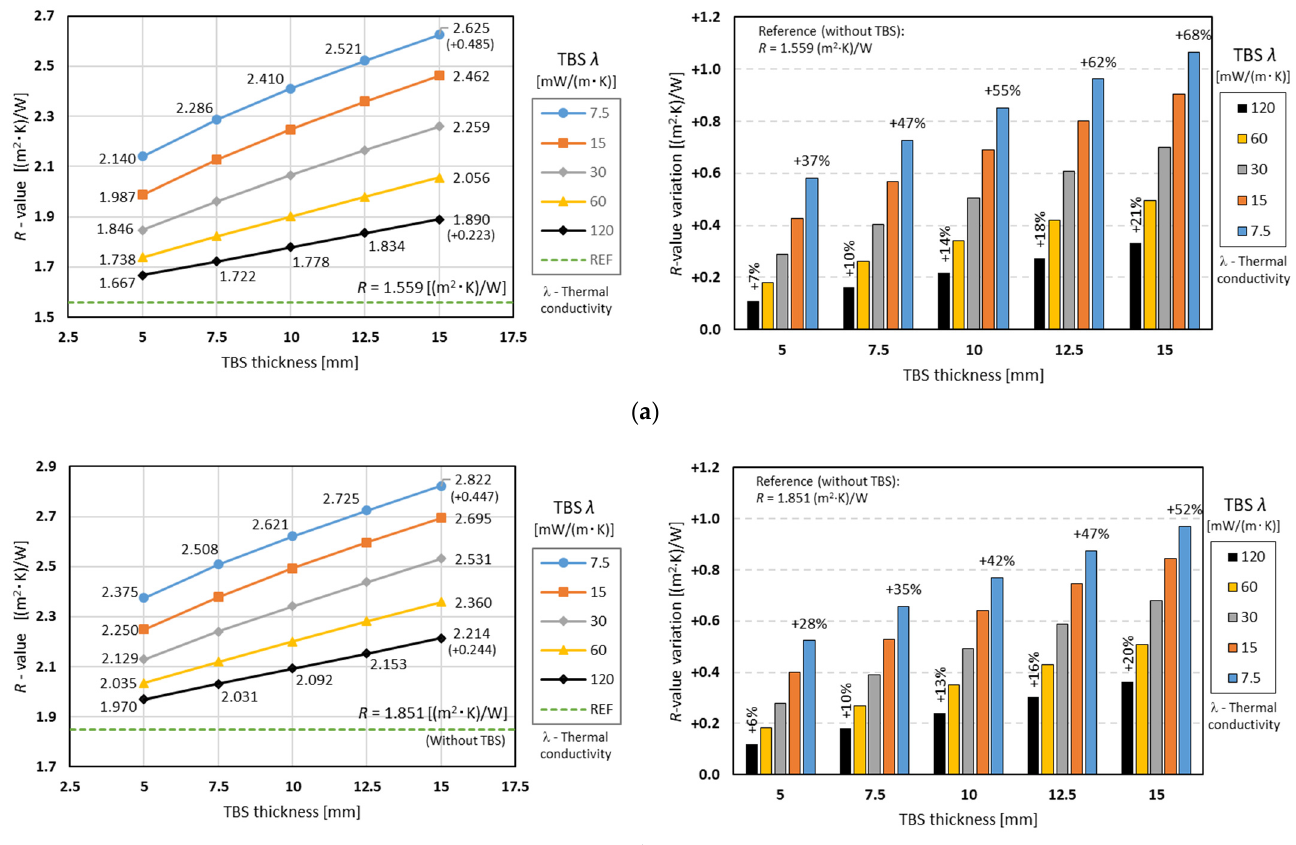
Figure 5. Conductive thermal resistances for partition LSF walls with one thermal break strip: 50 mm wide and variable thickness, for two different steel stud spacings. ( a ) 400 mm stud spacing. ( b ) 600 mm stud spacing.